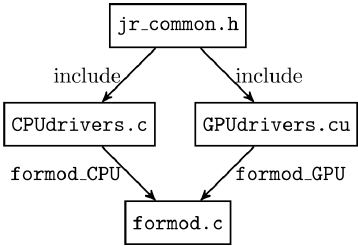
Figure 4. Common source code approach for CPUs and GPUs. The complete functionality of the JURASSIC forward model is provided via a joint header file included by both the specific CPU and GPU